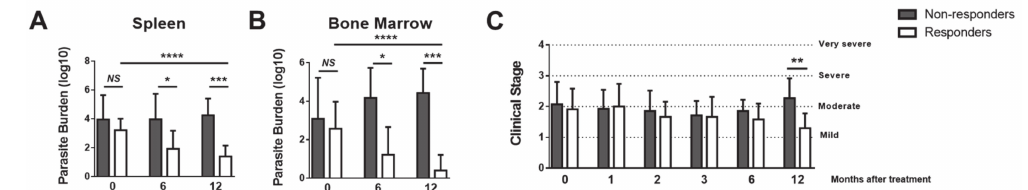
Figure 1. Responder dogs exhibited decreased parasite loads and improved the clinical